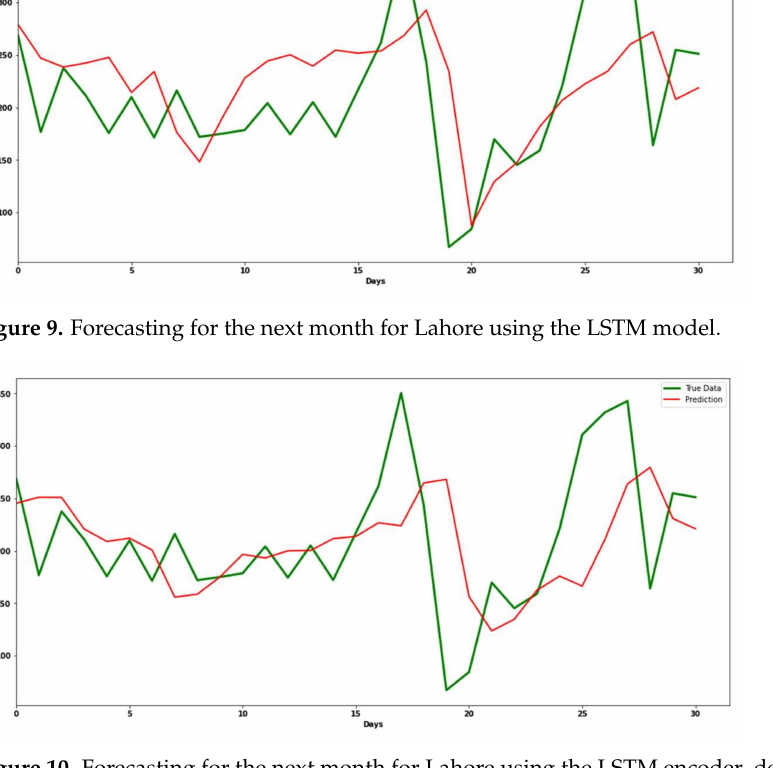
Figure 10. Forecasting for the next month for Lahore using the LSTM encoder–decoder model.